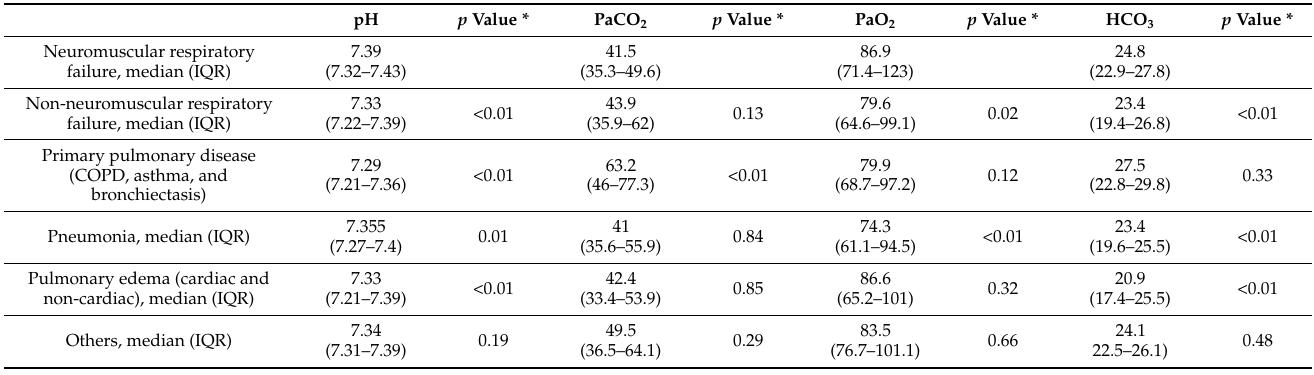
Table 2. Comparing ABG parameters between NMRF and non-NMRF